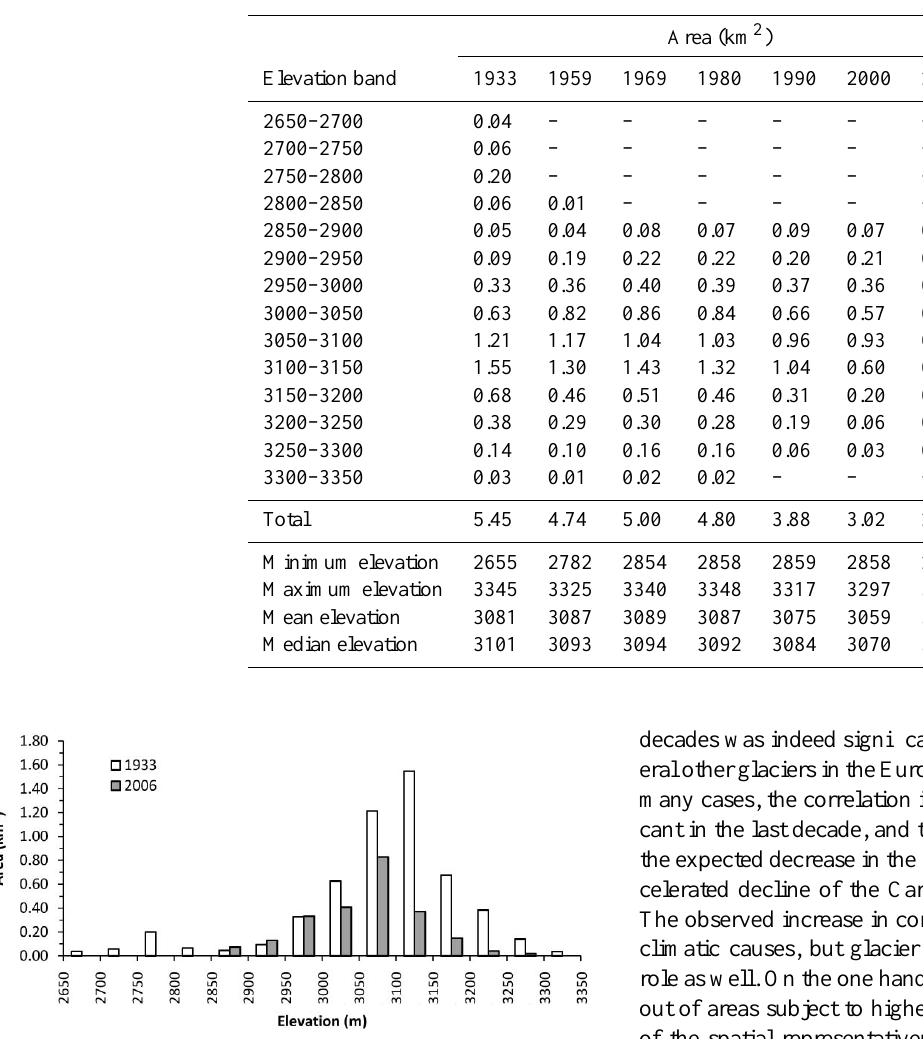
Table 2. Distribution of area vs. elevation on Careser Glacier from 1933 to 2006.